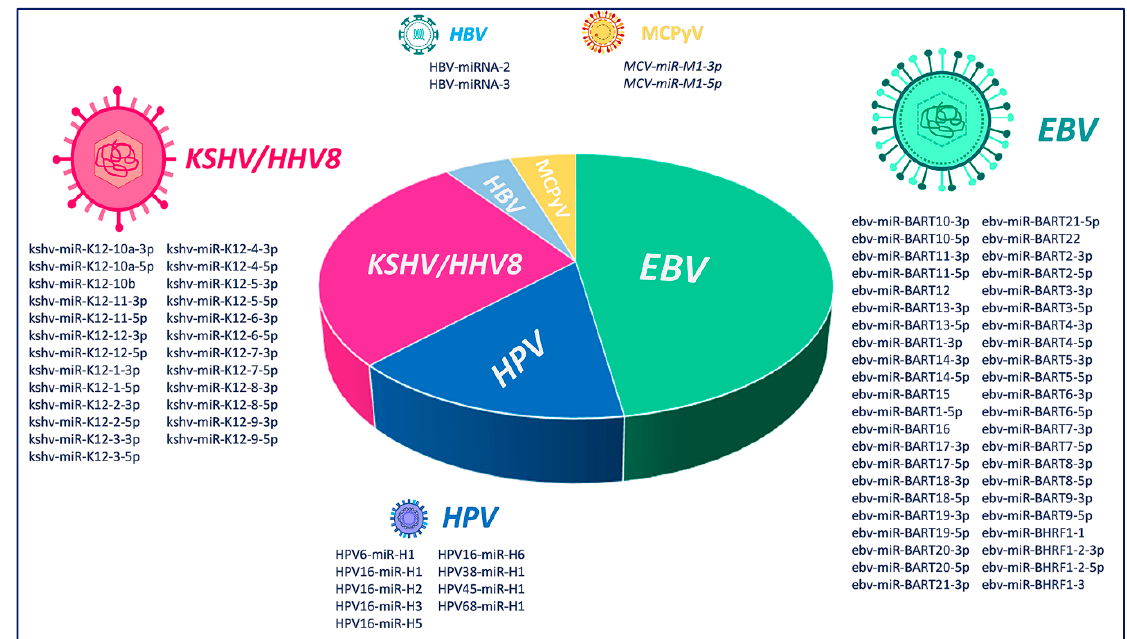
Figure 1. Graphical representation of the relative abundance of viral miRNA production by Epstein–Barr virus (EBV), Kaposi’s Sarcoma Herpesvirus/Human Herpesvirus-8 (KSHV/HHV8), Human Papillomavirus (HPV), Hepatitis C Virus (HCV), Hepatitis B Virus (HBV) and Merkel Cell Polyomavirus (MCPyV) viruses. Table 1. Overview of viral miRNA regulatory functions and targets.